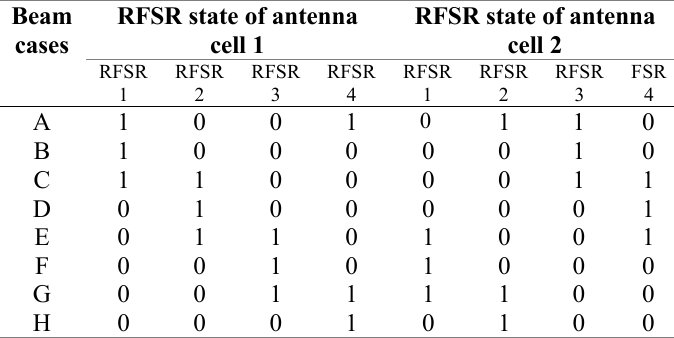
Table 1: Beam-switching control